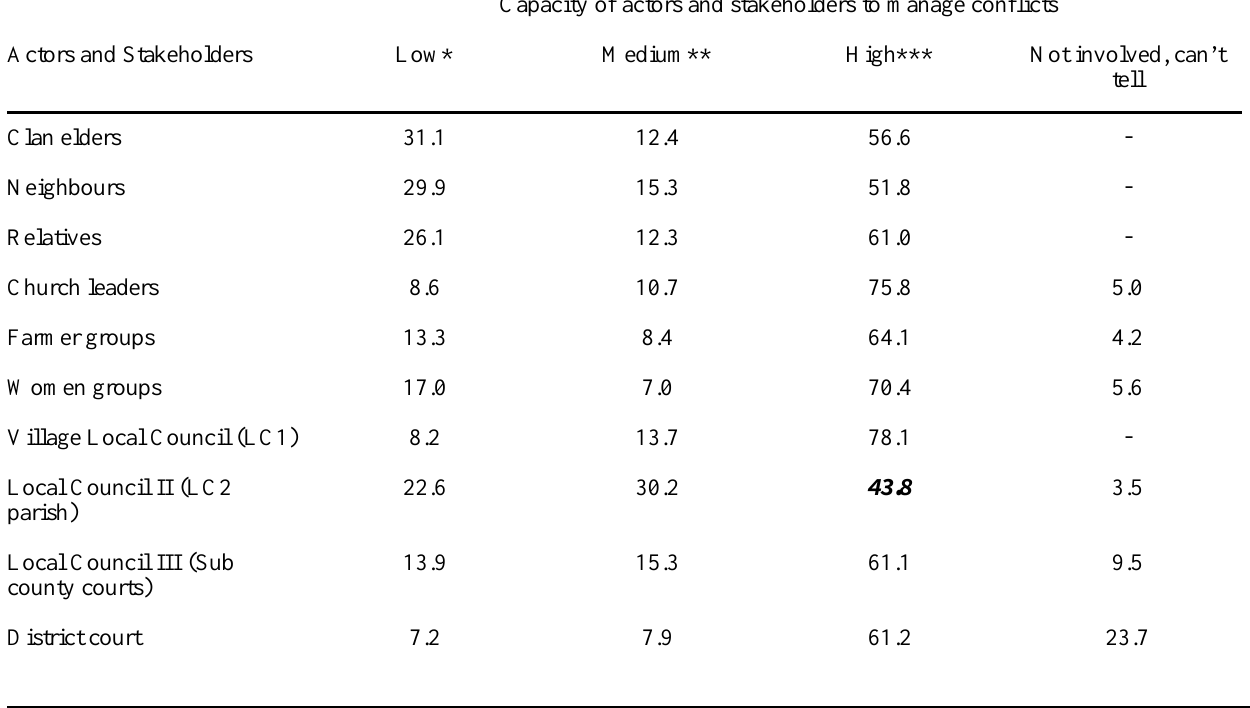
Table 4. Capacity of actors and stakeholders to resolve